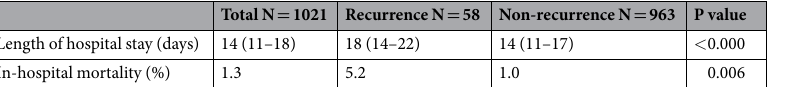
Table 1. Comparison of hospital stay and in-hospital mortality between the stroke patients in the recurrence group and the non-recurrence group.